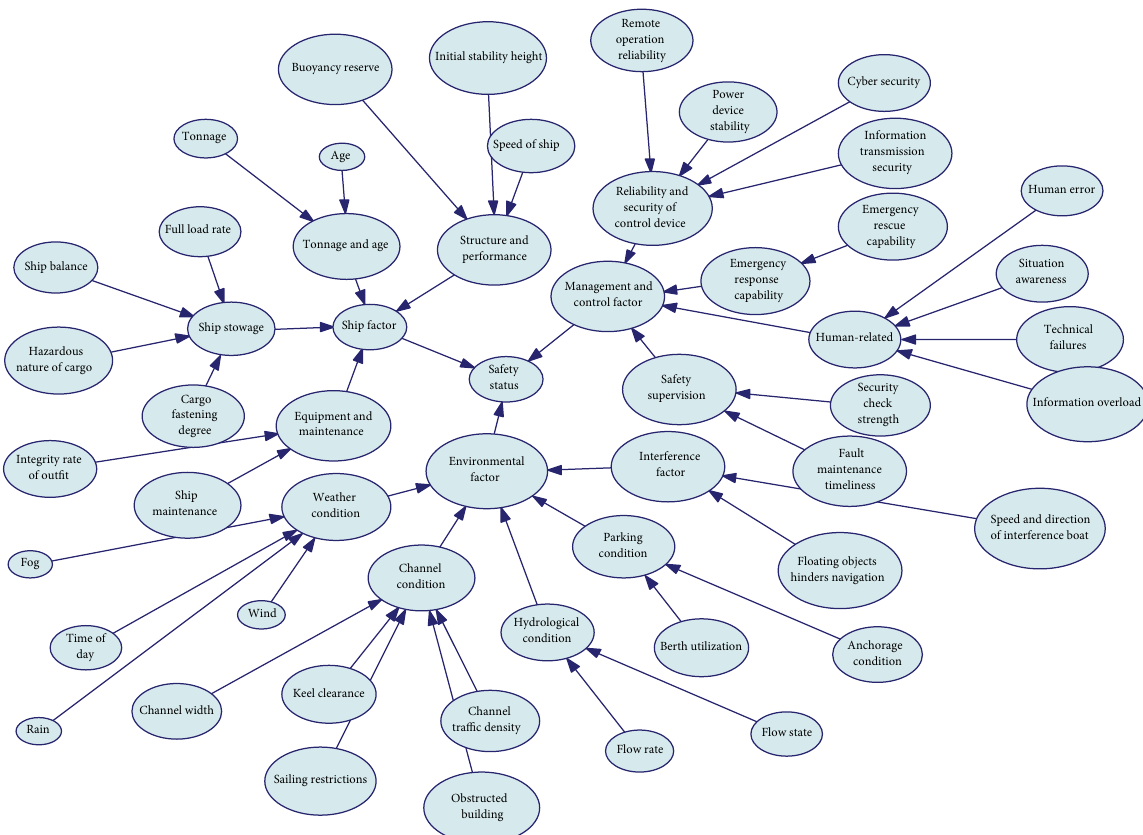
Figure 3: Bayesian network for risk of safety status of inland river unmanned